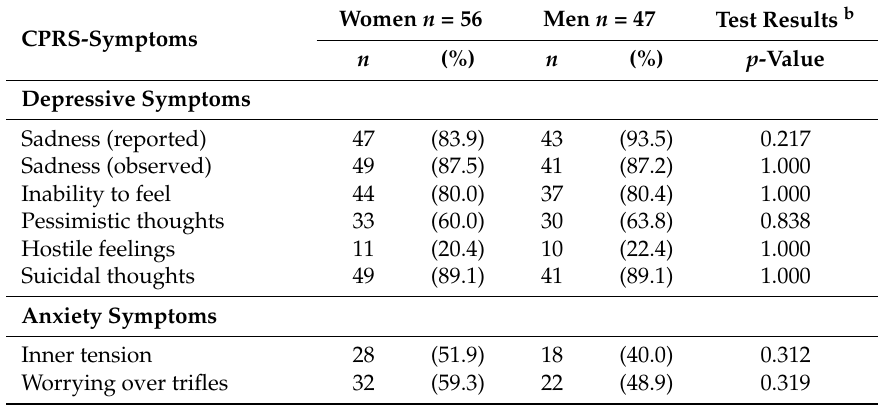
Table 2. Psychiatric symptoms in accordance with the Comprehensive Psychopathological Rating Scale (CPRS) a in hospitalized suicide attempters aged 70 and above by